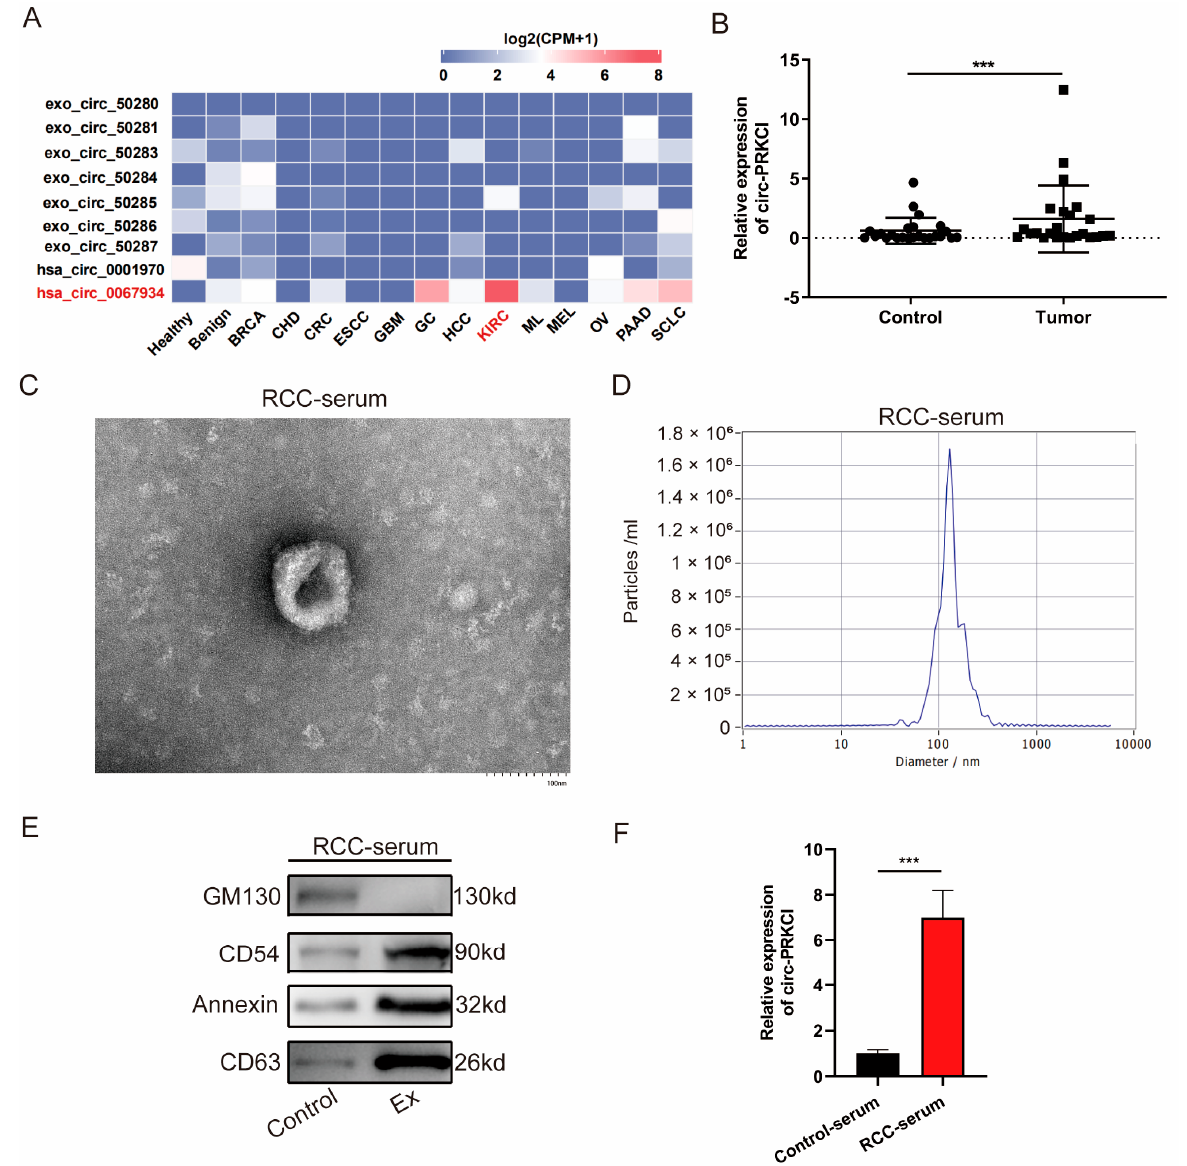
Figure 1. Exosomal circ-PRKCI was significantly upregulated in RCC tissues and serum. ( A ) The expression patterns of PRKCI related circRNAs in the plasma extracellular vesicles across cancer types in exoRBase database. ( B ) The relative expression of circ-PRKCI in RCC tissues and the adjacent non-malignant renal tissues. ( C , D ) Exosomes were isolated from RCC serum, and the morphology and size were examined by transmission electron microscopy (scale bar = 100 nm) and nanoparticle tracking analysis. ( E ) Protein expressions of GM130, CD54, Annexin, and CD63. ( F ) The relative expression of circ-PRKCI in exosomes isolated from RCC serum and healthy control serum. (*** p < 0.001).